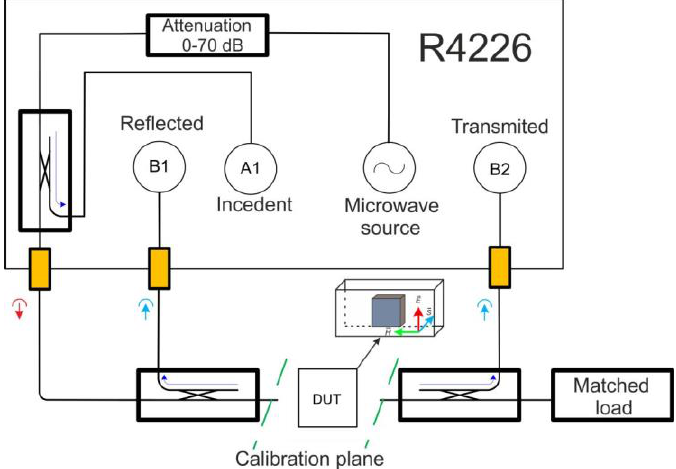
Fig . 1 . Block diagram of the measuring